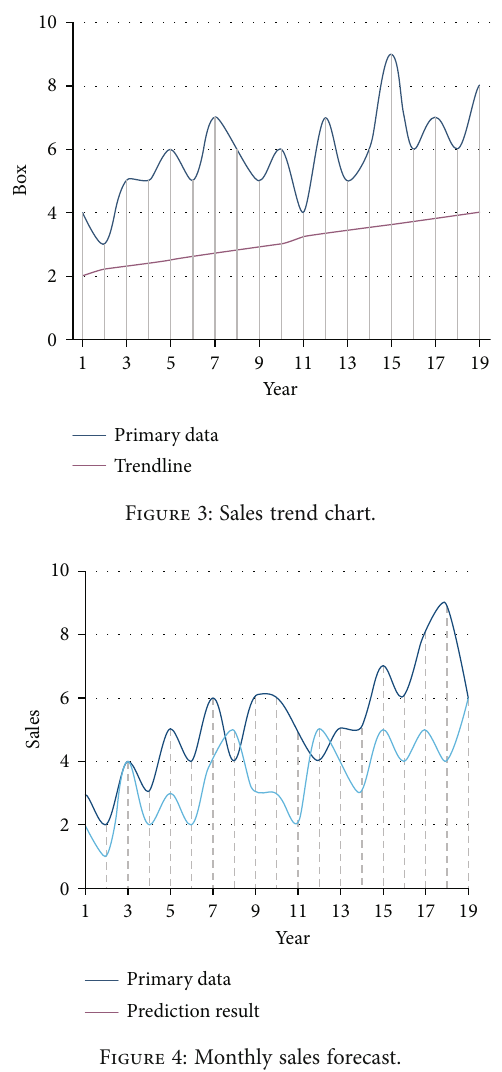
Figure 4: Monthly sales